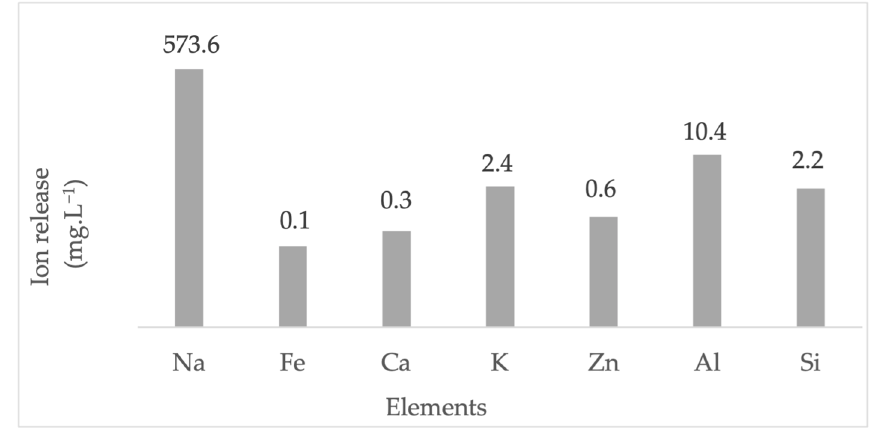
Figure 8. Elements released by the incorporation of lithium hydroxide nanoparticles over LTA zeolite. (Na, Fe, Ca, K and Zn were determined via AAS; Al and Si were determined using ICP-OES). The XRD pa tt erns of ZA-Li + and its parent ZA5 are depicted in Figure 9a. There XRD pa tt erns of ZA-Li + were similar to their parent ZA5; thus, the structure of LTA zeolite was not drastically a ff ected by the incorporation of Li + on LTA zeolite. LTA was indexed to the ence of solid nanoparticles dispersed over the surface of ZA-Li + . Under these conditions, ∼ = cubic crystal system and space group Fm-3c; after the incorporation of Li + on LTA zeolite, the coexistence of metal hydroxides Li(OH) at 10 − 5 (s) occurred in their ionic species Li +